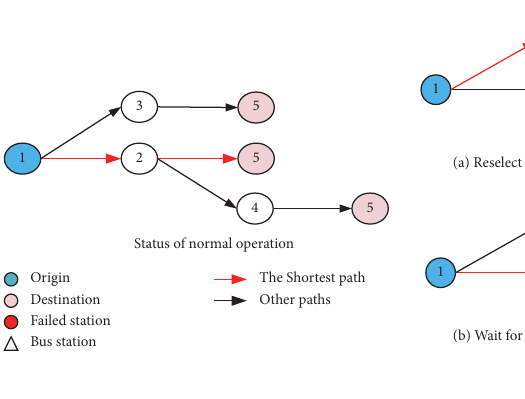
Figure 3: Passenger travel paths.